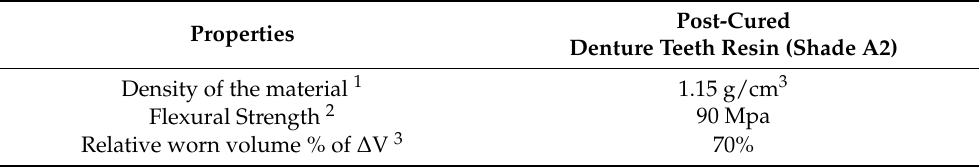
Table 2. Known properties of Denture Teeth Resin (Formlabs, Dentca). Properties